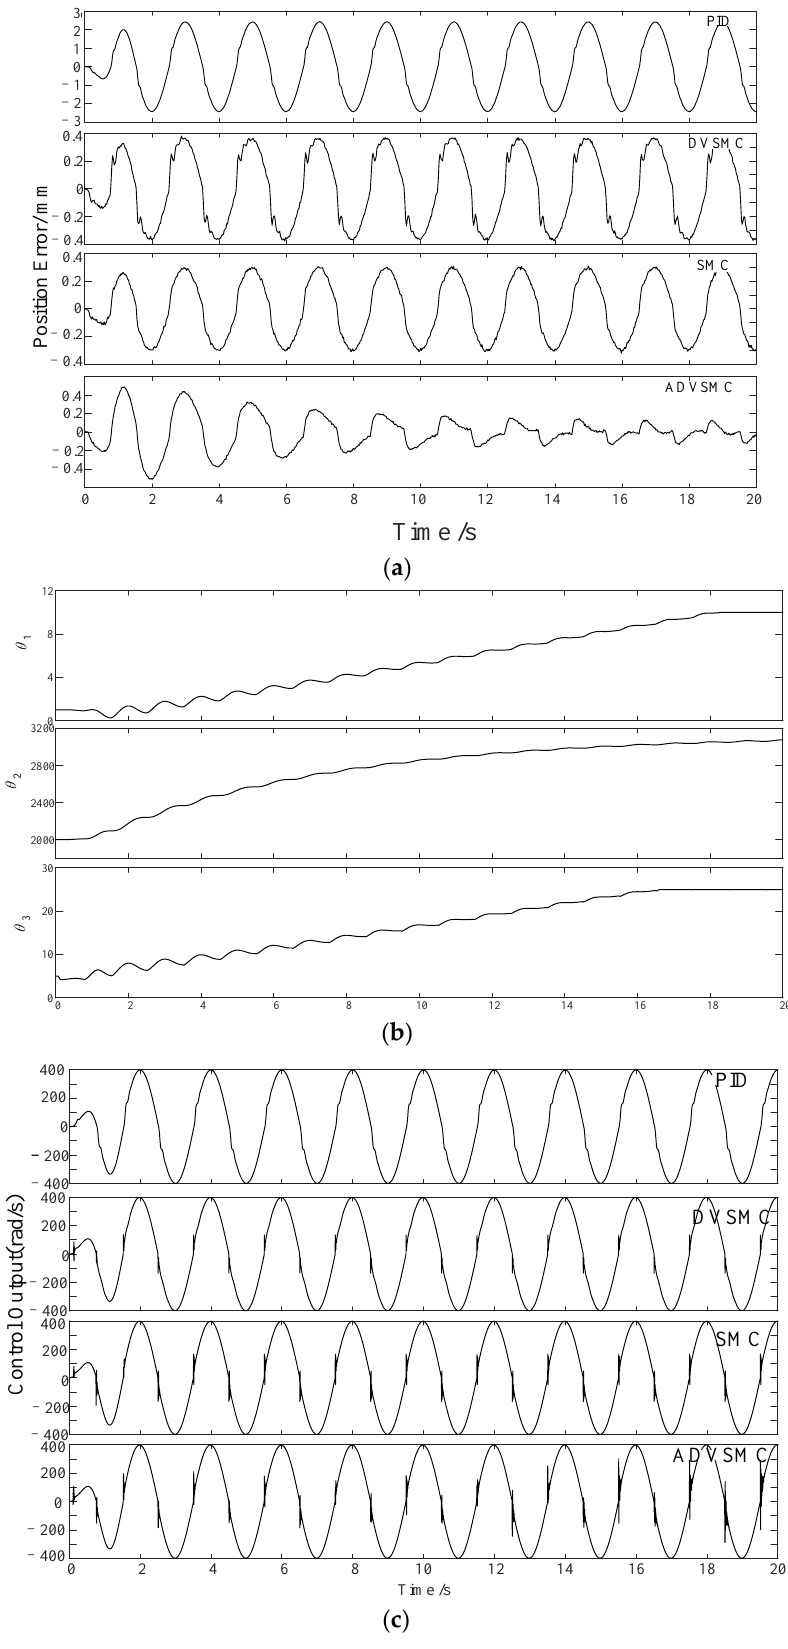
Figure 7. Experimental responses to 1 Hz sinusoidal signal: ( a ) tracking error; ( b ) parametric estimation; ( c ) control output.